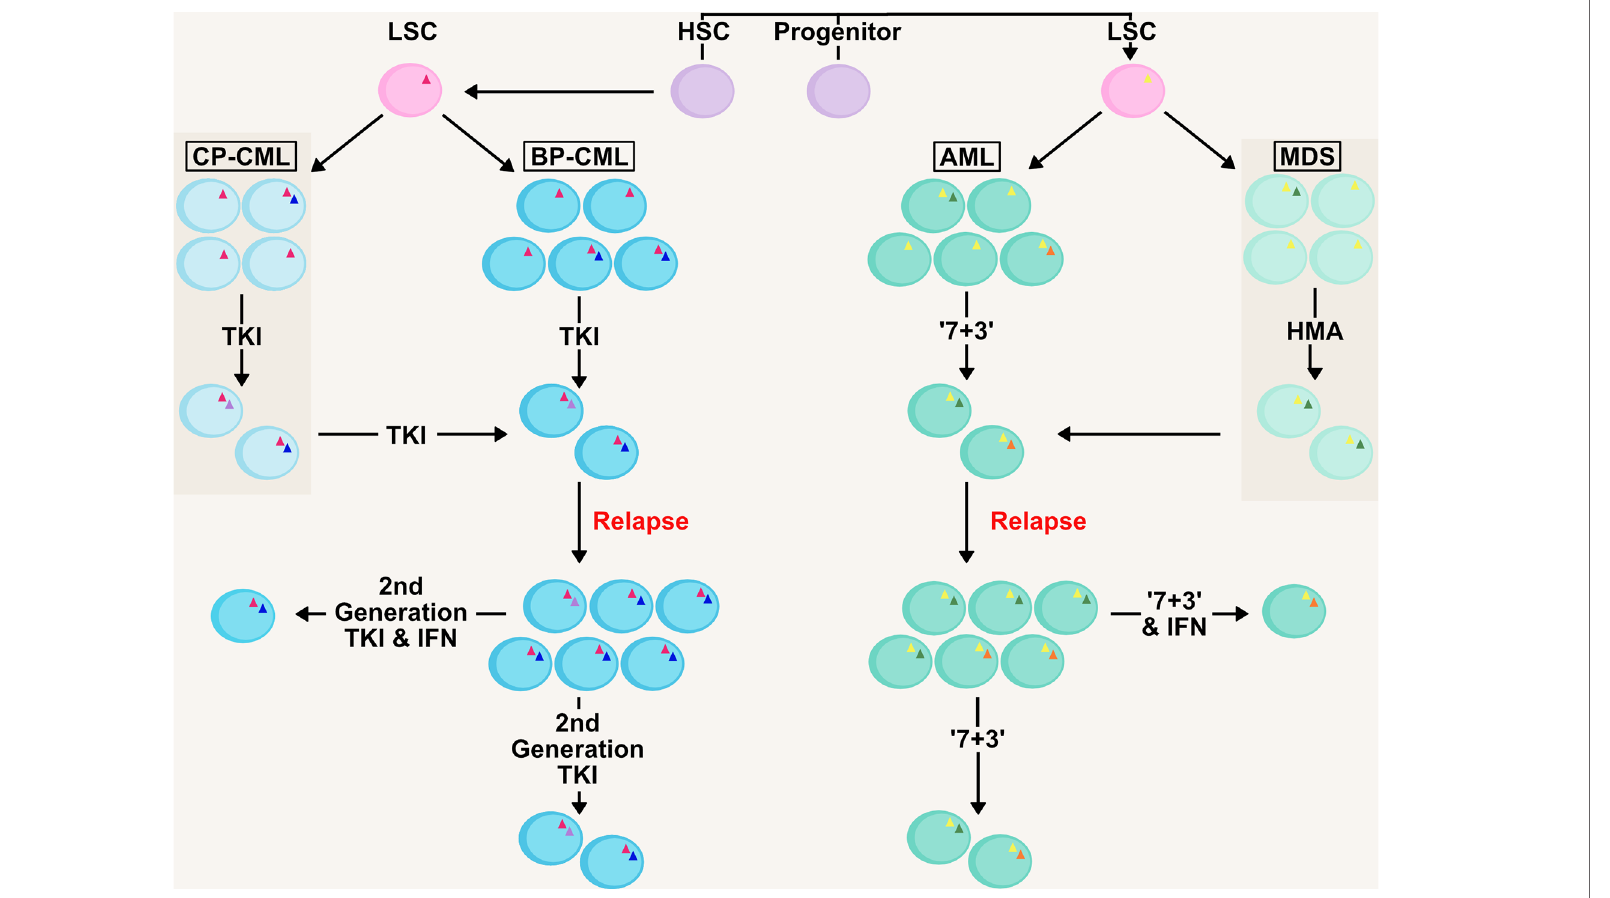
FIGURE 2 | Management of Clonality and MRD in AML/CML with IFN therapy. AML and CML are clonal diseases, presenting at diagnosis with a major immature blast clone and minor clones (denoted by mutations as triangles within cells) which develop due to mutations in the haematopoietic stem and progenitor pool generating the LSC. Initial therapy in both chronic-phase (CP-CML) and blast-phase (BP-CML) patients with a fi rst-generation tyrosine kinase inhibitor (TKI) against the BCR-ABL oncogene (pink triangle), such as imatinib, will reduce the bulk of CML blasts in the bone marrow and peripheral blood. However, it is not uncommon for resistant clones to persist that are refractory to this treatment. Later generation TKIs (e.g. nilotinib, dasatanib, ponatinib) may eradicate these clones but some mutations (e.g. BCR-ABL T315I; green circle) drive resistance to novel TKIs. Similarly, initial ‘ 7+3 ’ therapy in AML (7 day treatment with the pyrimidine analogue cytarabine, in conjunction with an anthracycline, such as daunorubicin, for the fi rst 3 days) and HMA-therapy (hypomethylating agent) in MDS will eradicate the bulk of leukaemic blasts (such as those containing initiating mutations; yellow triangle) in the patient. However, clones refractory to these therapies (including those with signalling mutations; blue and orange circles) will drive relapse in MDS/AML patients, as well as transformation from MDS to AML. Management of measurable residual disease (MRD) in myeloid malignancies is critical to preventing relapse. Therapies based on IFNs could target the clones resistant to front-line therapies and deliver longer